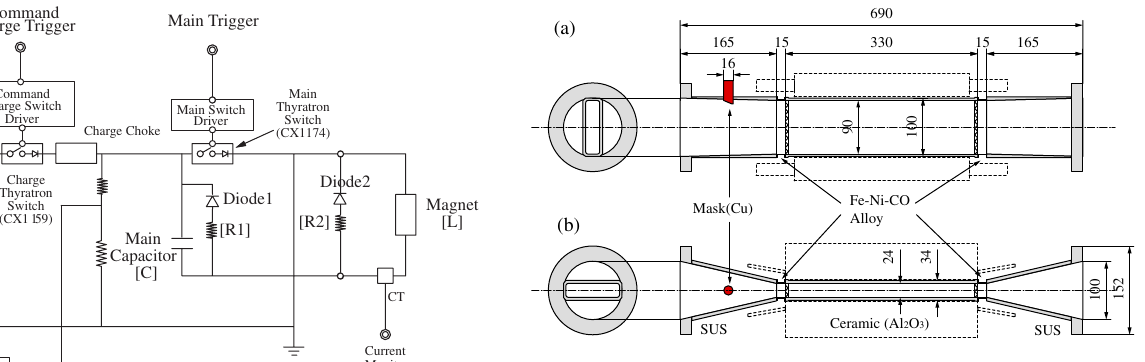
FIG. 17. (Color) Ceramic chamber for the PQM: (a) top view and (b) side view of the chamber. The inner aperture of the chamber is rectangular; it is 90 mm in width by 24 mm in height. The thickness of the chamber is 5 mm. The outer aperture is rectangular; it is 100 mm in width by 34 mm in height. The inner side of the chamber is coated with a molybdenum-titanium (Mo- Ti) layer of 3 (cid:1) m thickness, and an absorber mask of copper (Cu) is also attached. The dashed line indicates the PQM.